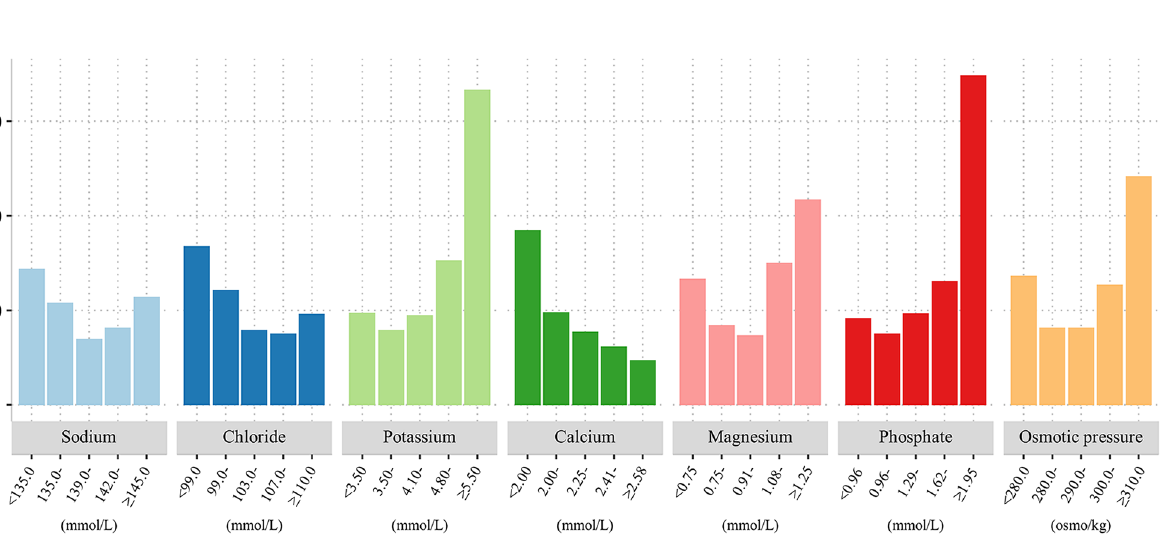
Table 1. The baseline and angiographic characteristics of the two groups. BMI body mass index, eGFR estimated glomerular filtration rate, NT-proBNP N- terminal pro-B-type natriuretic peptide, LM left main, LAD left anterior descending, LCX circumflex, RCA right coronary artery.